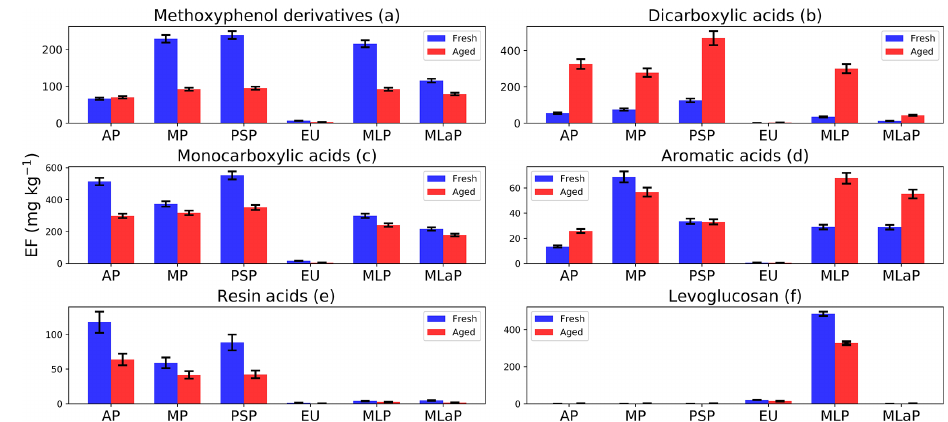
Figure 7. Fuel-based emission factors (EFs) of organic compounds assigned to six chemical groups for six different fuels: Alaskan peat (AP), Moscow peat (MP), Pskov peat (PSP), eucalyptus (EU), Malaysian peat (MLP), and Malaysian agricultural peat (MLaP). EFs are presented as a sum of gas- and particle-phase species mass measured in fresh and OFR-aged BB emissions (in units of mgkg − 1 ; mass of emissions per fuel mass combusted). We did not burn fuels in replicates, and the standard-deviation (SD) values of all chemical groups were calculated based on the replicate analysis of similar fuels (with the same experimental conditions) from our previous campaign based on the data reported by Yatavelli et al.